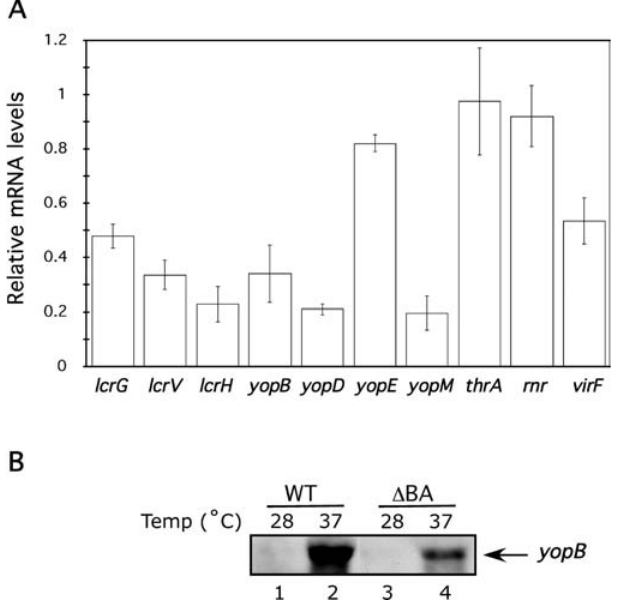
Figure 8. The smpB-ssrA Mutation Affects Levels of Yop Transcripts (A) Relative mRNA levels of the indicated Yops were determined by quantitative real-time PCR as described in Materials and Methods. Each value represents the average of three independent experiments. Standard deviation bars are indicated on each column. (B) Quantitative real-time PCR data were independently confirmed by Northern blot analysis of yopB mRNA. Total RNA samples were resolved on a 1% agarose-formaldehyde gel, transferred to nylon membranes, and probed with a biotin-labeled yopB specific probe. WT, wild type. DOI: